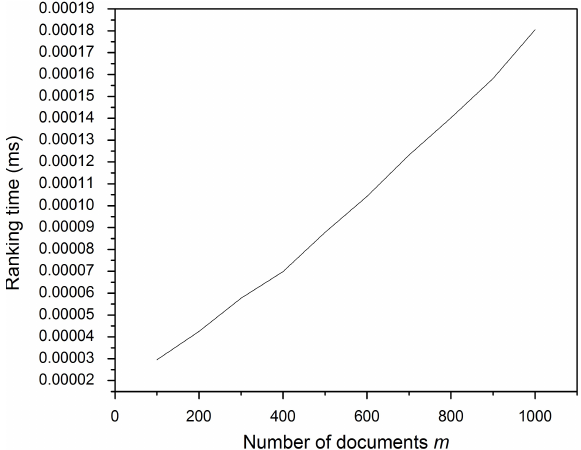
Figure 8. Ranking time: increasing the fingerprint